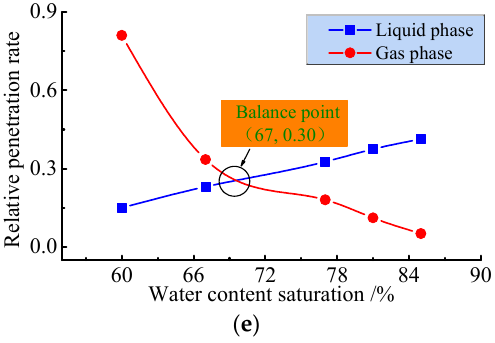
Figure 10. Relationship between relative permeability and water content saturation. ( a ) Sample ZS-01; ( b ) Sample ZS-02; ( c ) Sample ZS-03; ( d ) Sample ZS-04; ( e ) Sample ZS-05.